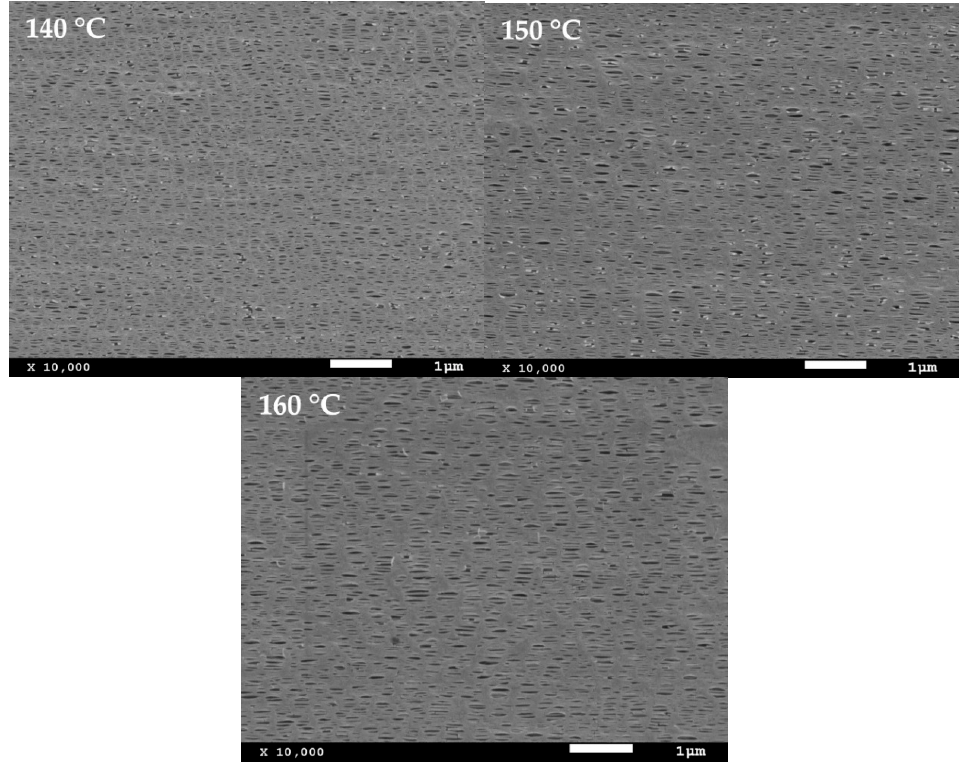
Figure 5. SEM micrographs and DSC thermograms of sample H-20B annealed at different temperatures/( a ) annealed precursor films, and ( b ) membranes (second stretching step at 140 °C).